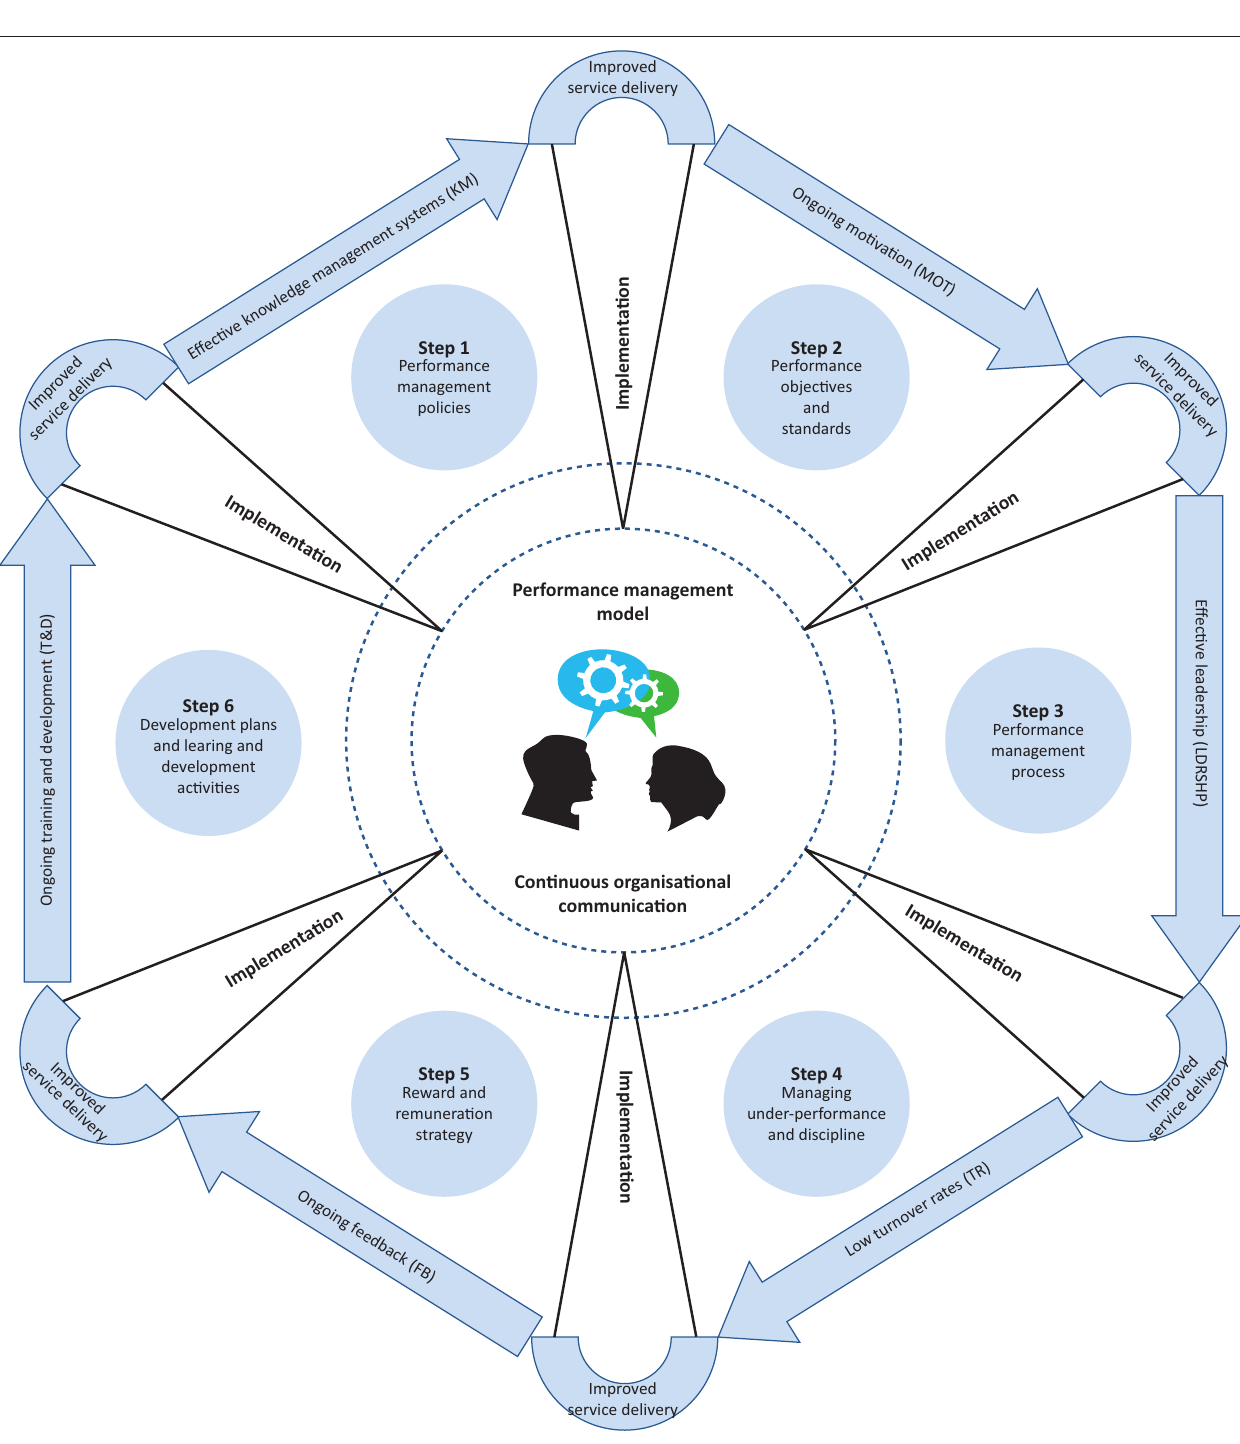
Guideline 3 – Performance environment : The factors linked to the performance environment should enable a well- functioning and conducive working environment, which positively supports and promotes improved performance.